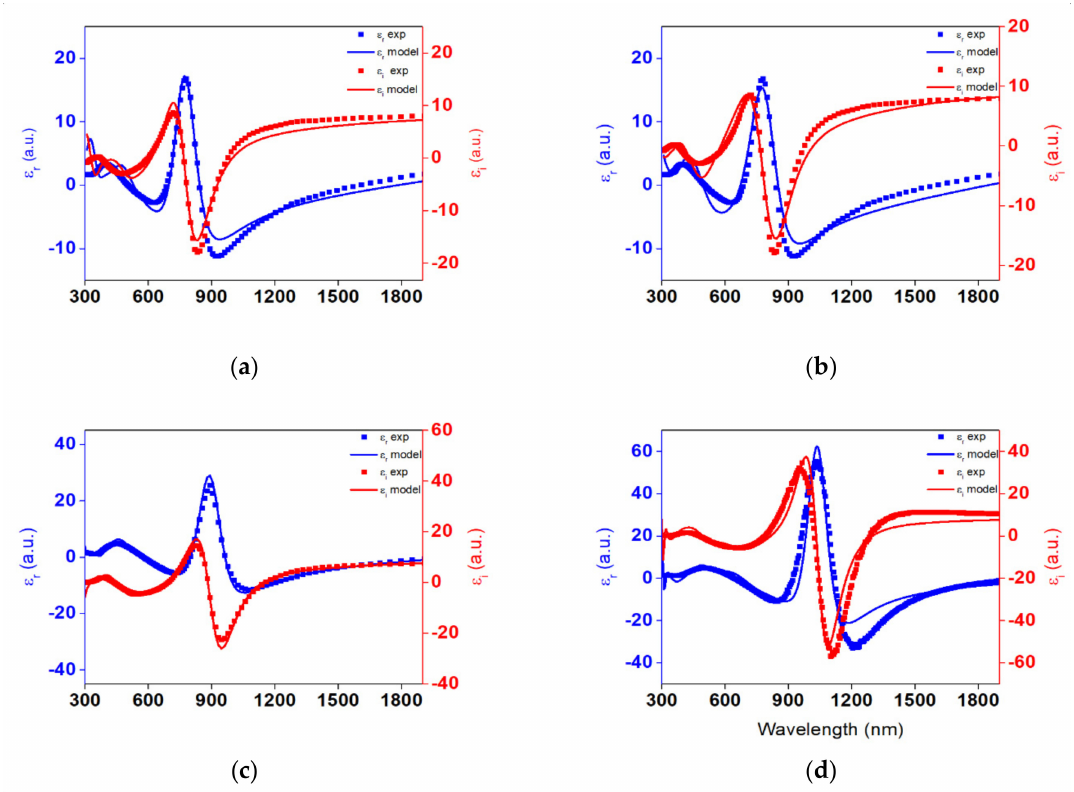
Figure A5. Comparison between experimental and fitted pseudo-imaginary and real dielectric functions ( ε i , ε r ) of Ag- NPs/PMMA film/c-Si structurea at different concentrations of Ag precursor: ( a ) 10; ( b ) 20; ( c ) 30; and ( d ) 40 mM.